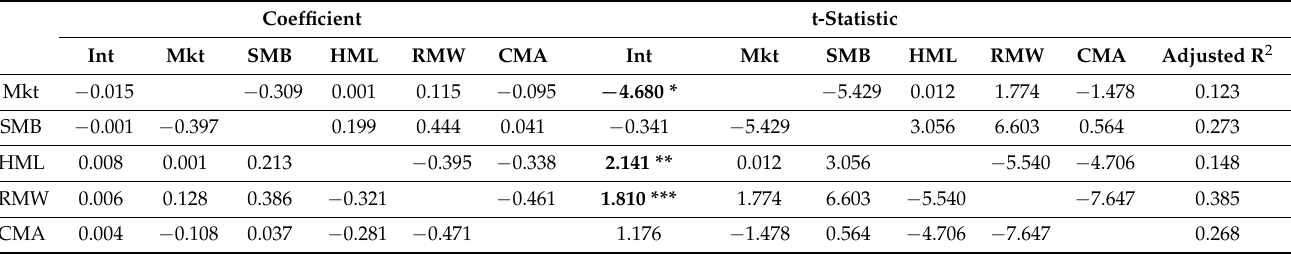
Table 4. Factor spanning